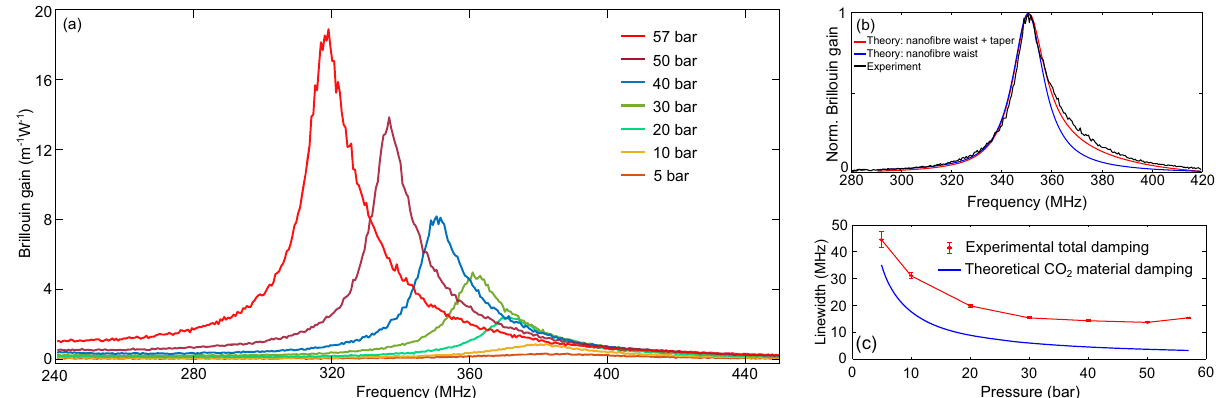
Fig. 5 Experimental Brillouin gain spectra in the nano fi bre placed in a gas cell fi lled with CO 2 . a Measured Brillouin gain spectra along the nano fi bre gas cell fi lled with CO 2 at different pressures. b Normalised Brillouin gain spectra in 40 bar CO 2 obtained in a nano fi bre with a waist of 740 nm. The blue line shows the theoretical Brillouin spectrum at the nano fi bre waist; the red line shows the compound theoretical Brillouin spectrum along the nano fi bre waist and the tapered region. The black line shows the experimental Brillouin spectrum along the nano fi bre in the gas cell fi lled with 40 bar CO 2 . c Measured Brillouin linewidth de fi ned as twice the value of the left half-width measured spectrum using a Lorentzian fi tting on the experimental curves in ( a ). Each red data point shows the estimated mean and the RMS error bar for a total of 10 measurements at each pressure. The blue line shows the theoretical Brillouin linewidth of free-space CO 2 gas at different